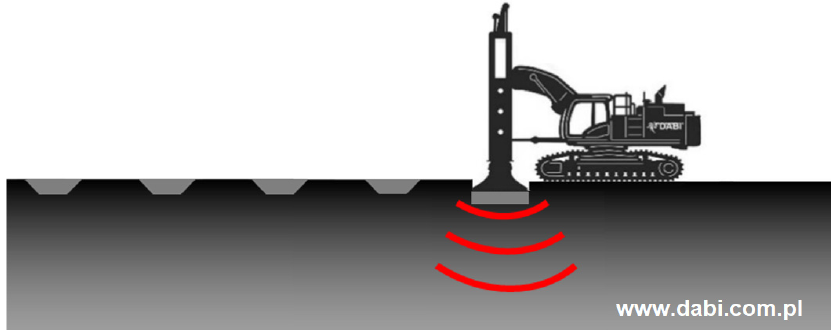
Figure 16. Graphics showing the RIC impulse compaction technology (RIC, graph. by P. Do- brzycki).